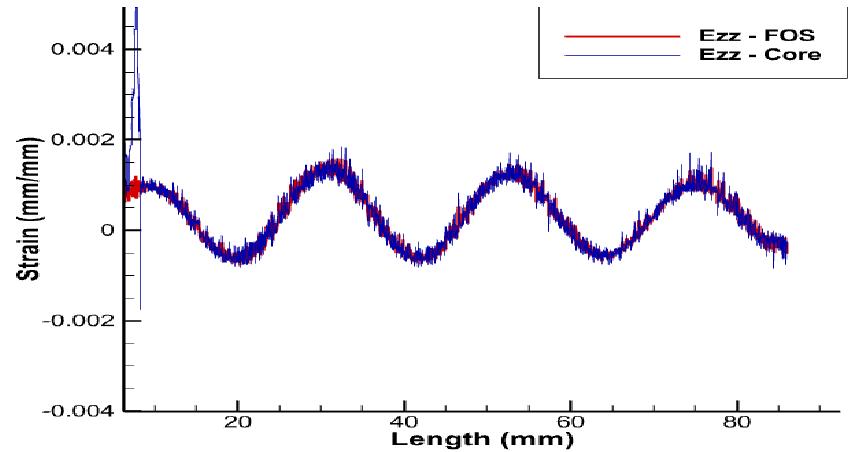
Figure 16. E zz strain for helical arrangement of